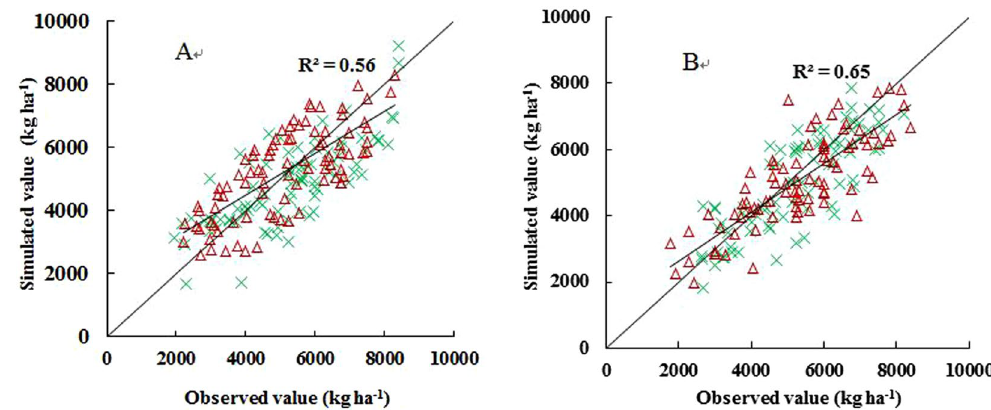
Figure 4. Comparison between simulated and observed values of grain yield in wheat at the regional scale with the CERES-Wheat ( A ) and WheatGrow ( B )